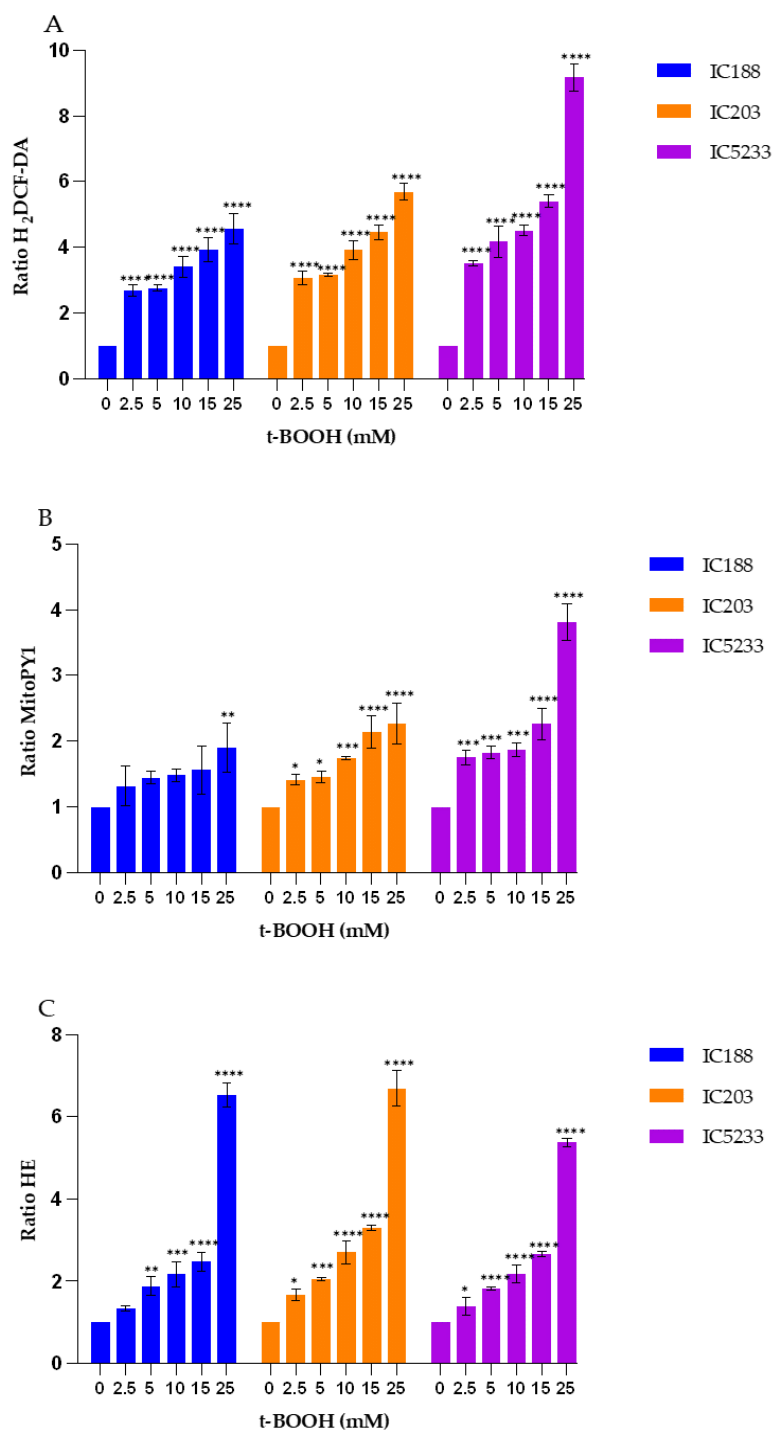
Figure 7. Fluorescence response to exogenous t-BOOH of the fluorescent probes ( A ) H 2 DCF-DA, ( B ) MitoPY1 and ( C ) HE in the strains IC188, IC203 and IC5233. Results are the mean ± SD (n = 3) of the fluorescence ratios of the product resulting from intracellular probe oxidation. (* p < 0.05, ** p < 0.01, *** p < 0.001 and **** p < 0.0001 in Anova test).